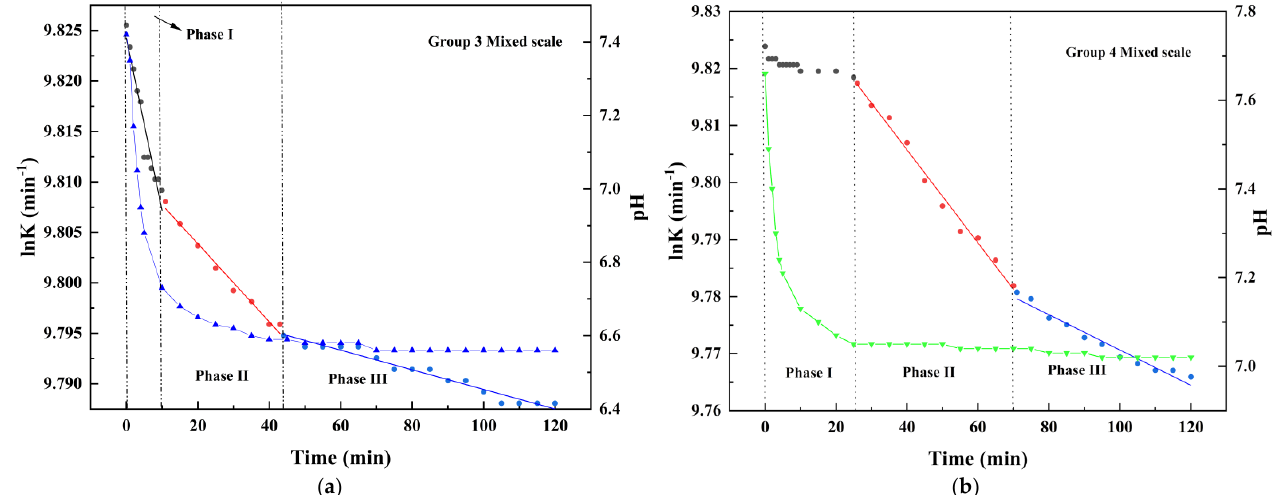
Figure 5. The change curve of conductivity logarithm and pH with time in Groups 3 ( a ) and 4 ( b ).